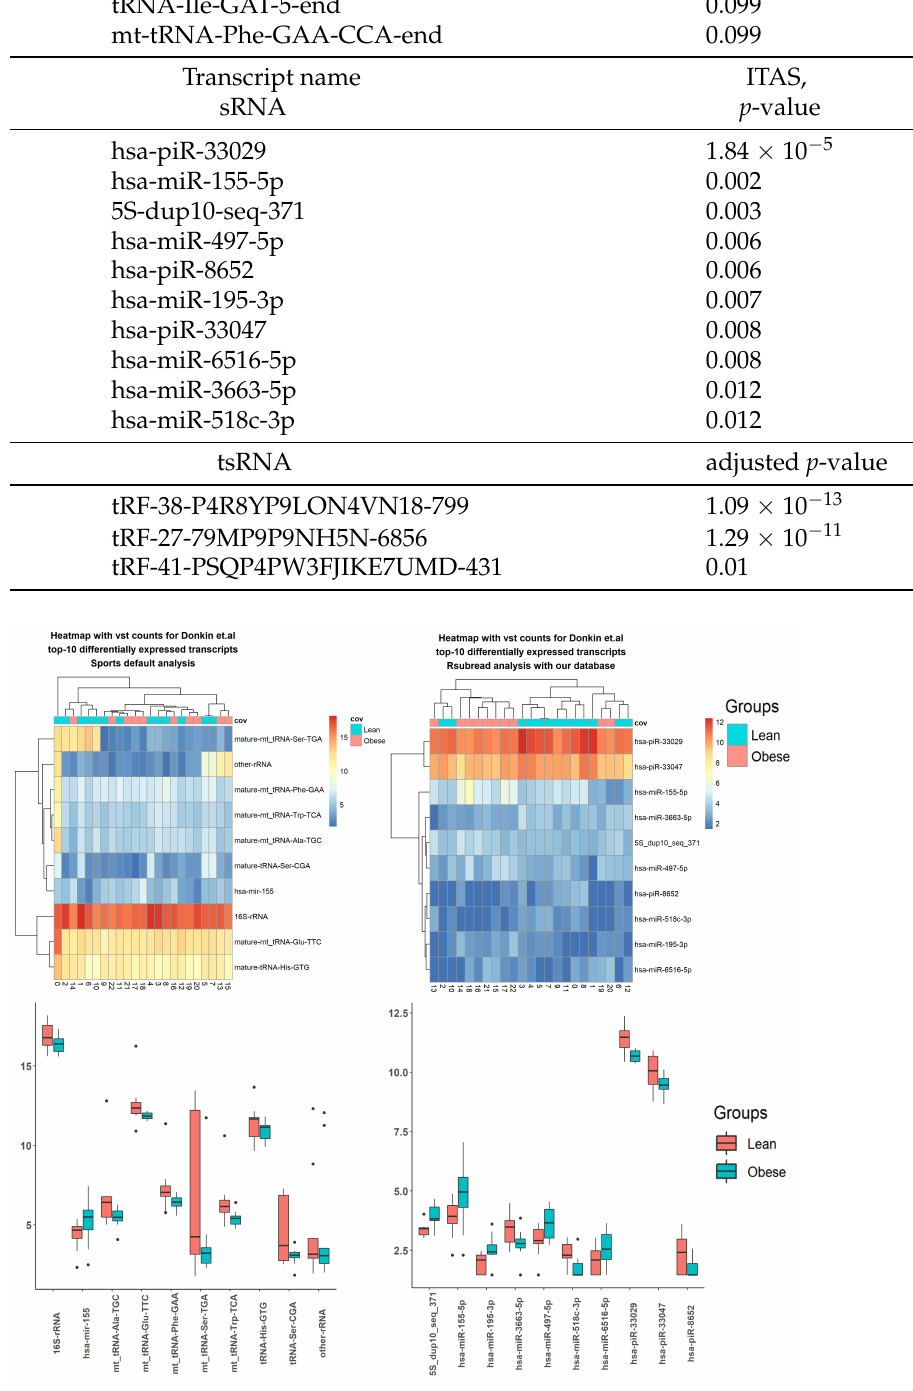
Figure 4. Top 10 differentially expressed small RNA (sRNA) using Donkin et al.’s data, processed with SPORTS vs. Integrated Transcript Annotation for Small RNA (ITAS)-based genome alignment (bowtie + Rsubread)